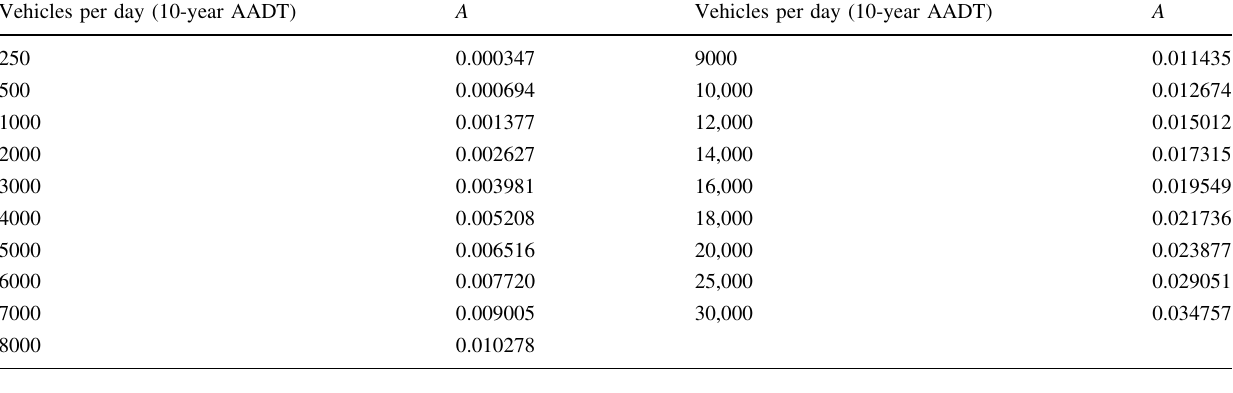
Table 4 A values based on 10-year annual average daily traffic (AADT) Vehicles per day (10-year AADT)